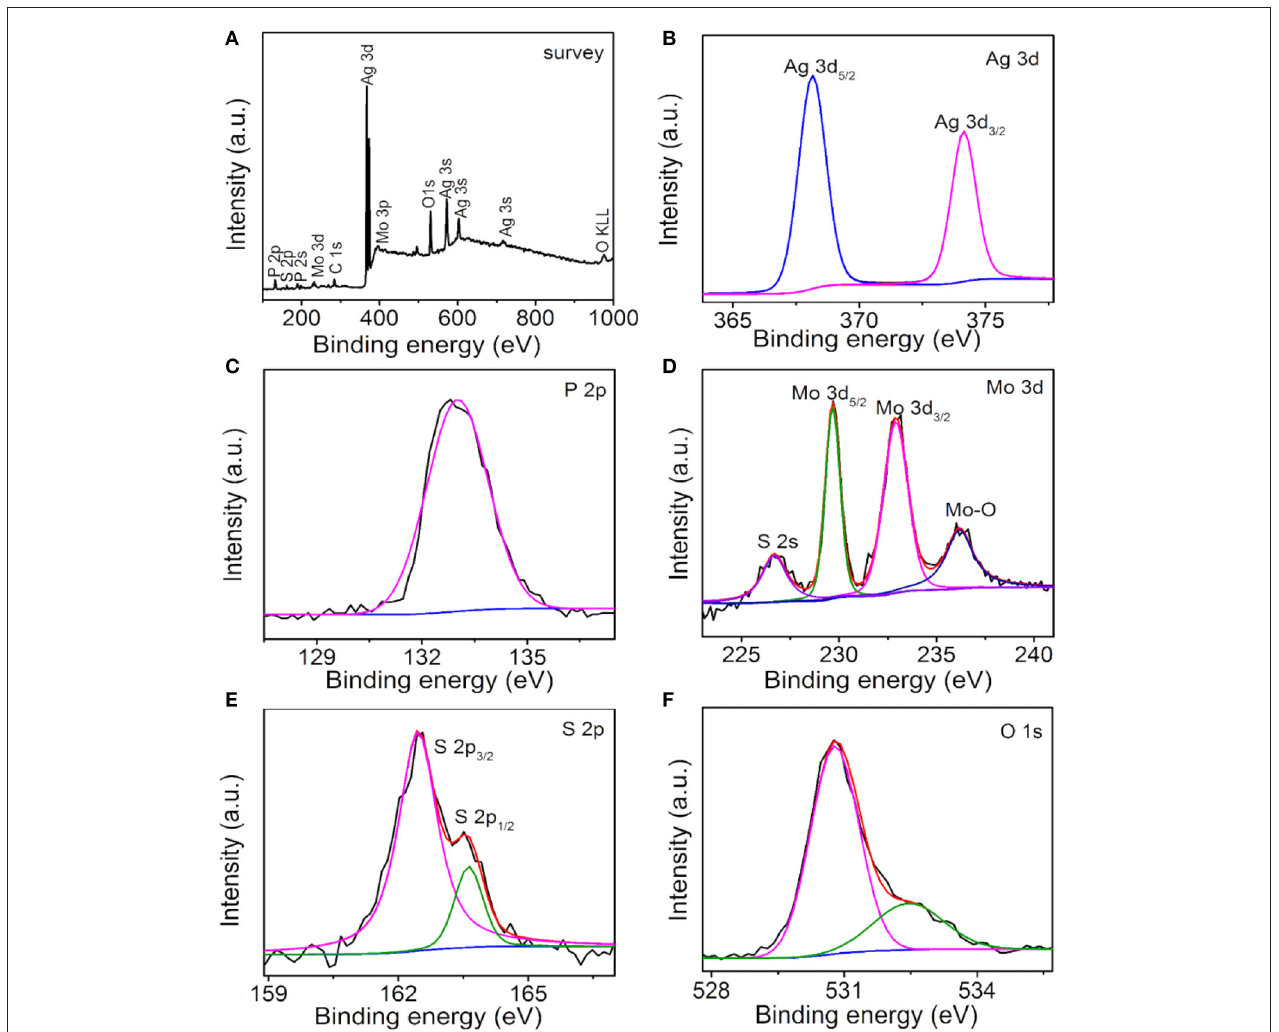
FIGURE 4 | XPS spectra of AM-200: Survey (A) , Ag 3d (B) , P 2p (C) , Mo 3d (D) , S 2p (E), and O 1s (F) .